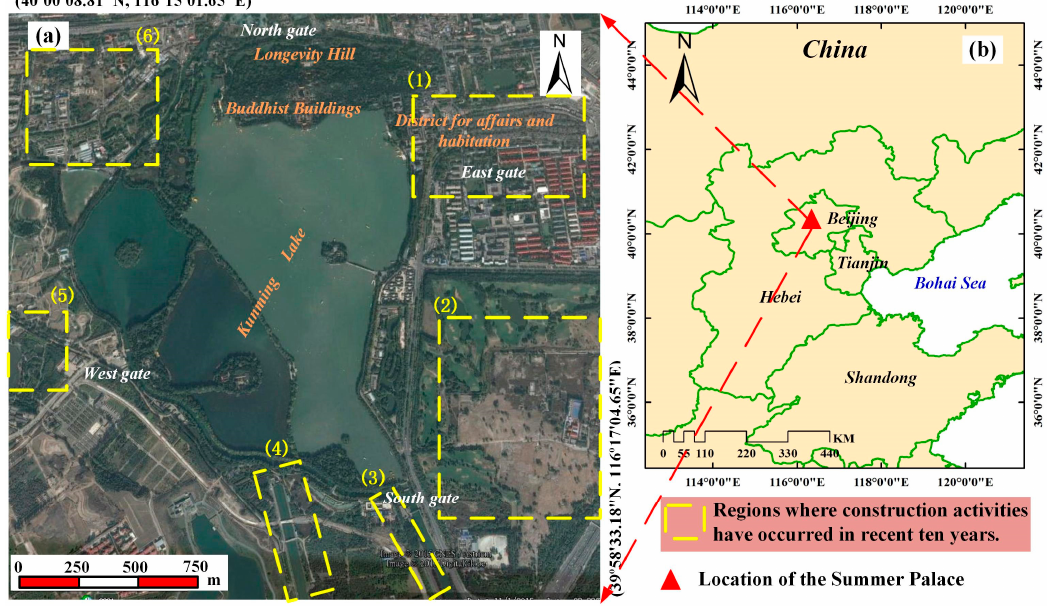
Figure 1. ( a ) Summer Palace study area (courtesy of Google Earth) with construction zones indicated by yellow dashed lines; and ( b ) location of the Summer Palace.